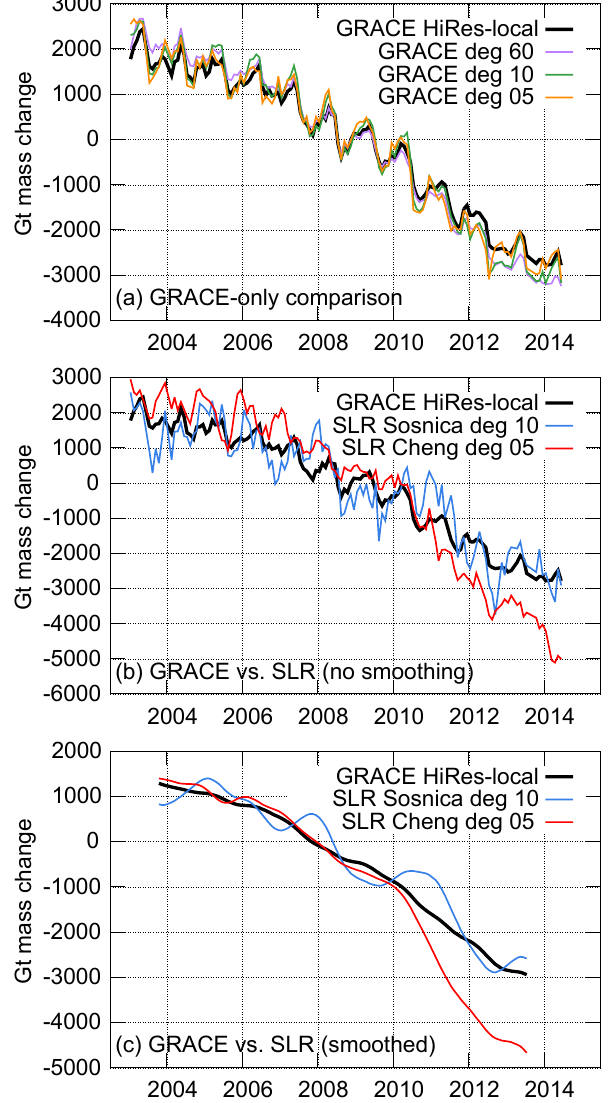
Figure 3. Comparisons of inverted GRACE and SLR mass sig- nals, over Greenland and Antarctica combined. (a) GRACE-only comparison, for different maximum degree/orders, relative to the high-resolution, local GRACE inversion. (b) SLR comparison. (c) Low-pass SLR comparison, after applying a 400-day (13 month)